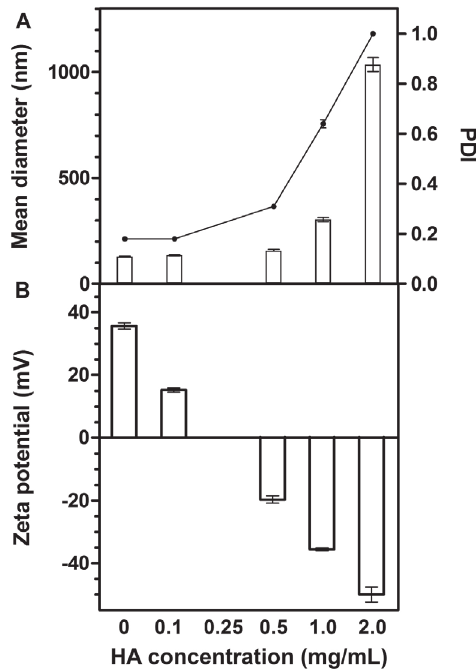
FIGURE 1 – Influence of HA concentration in mean globule diameter and PDI (A) and in zeta potential (B) of ATRA-loaded NE in the coating